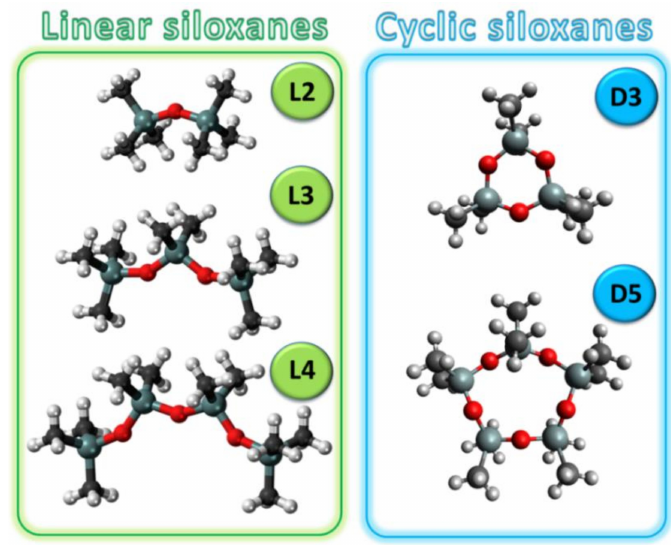
Figure 1. Structures of siloxanes used in the